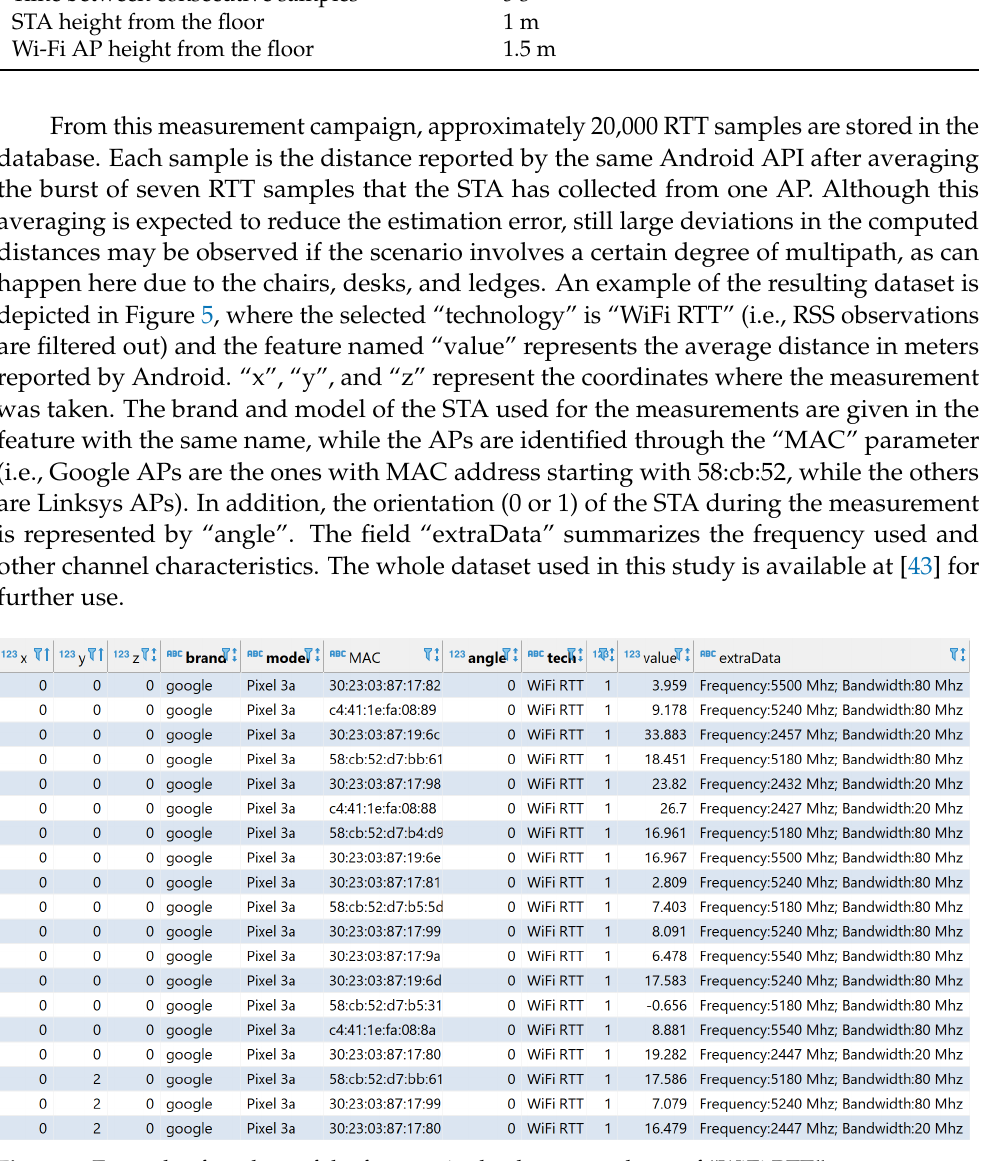
Figure 5. Example of a subset of the features in the dataset made up of “WiFi RTT” measurements. The feature named “value” represents the average distance measured at given positions in the selected